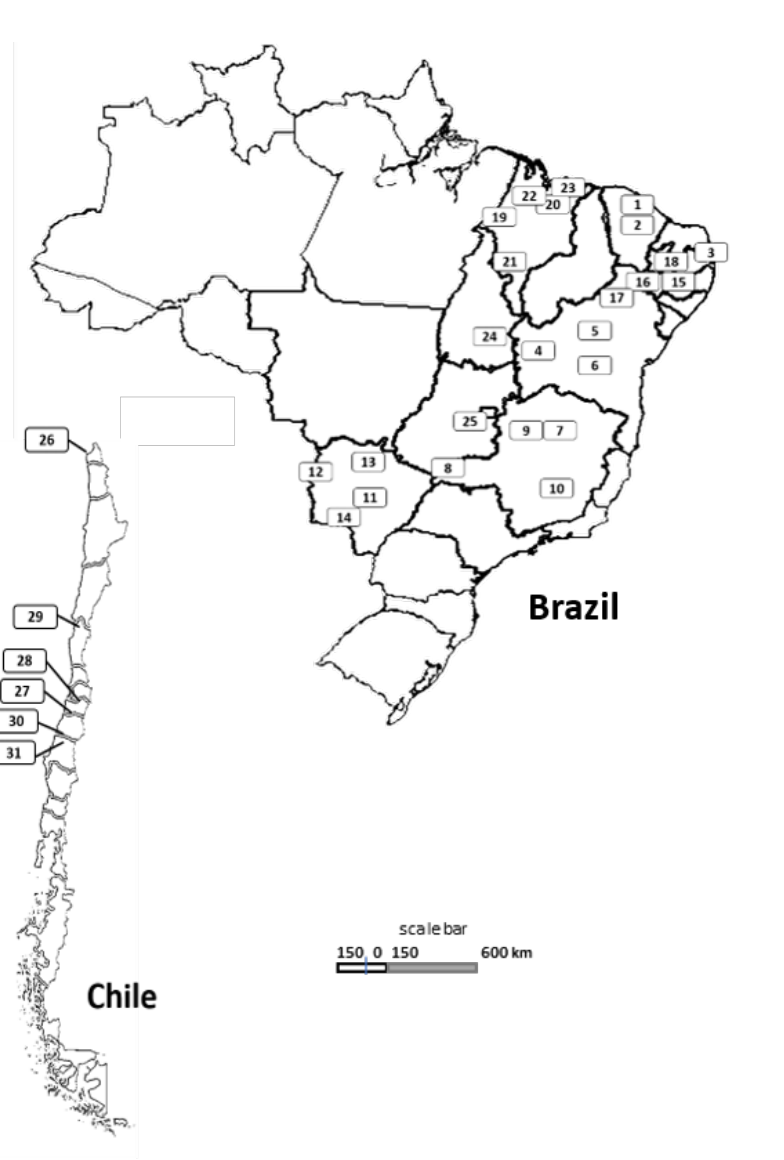
Figure 2. The accumulated solar radiation was collected from thirty-one cities in Brazil and Chile within the high potential region for solar energy